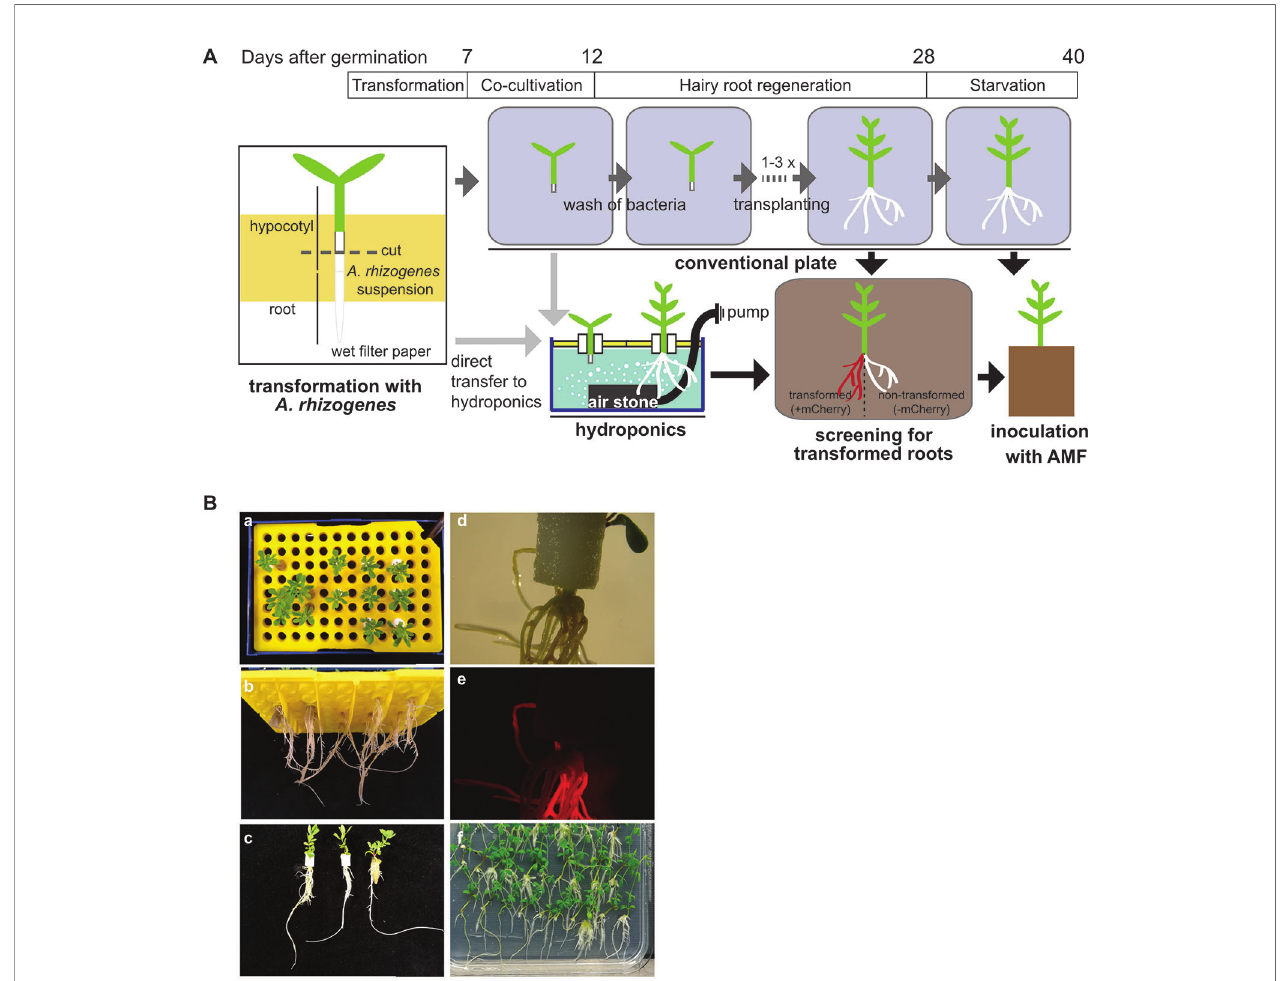
FIGURE 4 | Generation of hairy roots in tip hydroponics. (A) Schematic representation of hairy root growth using tip-wick hydroponics. (B) Images of mCherry transformed hairy roots of Lotus japonicus at 4 weeks post-transformation: (a – c) top, bottom and side view of seedlings grown in hydroponics. Scale bar: 20 mm; (d, e) bright fi eld and fl uorescence image of hairy roots generated in hydroponics expressing mCherry as a transformation marker, scale bar: 5 mm; 6. (f) Hairy roots of the same transformation experiment cultivated in square Petri dishes.